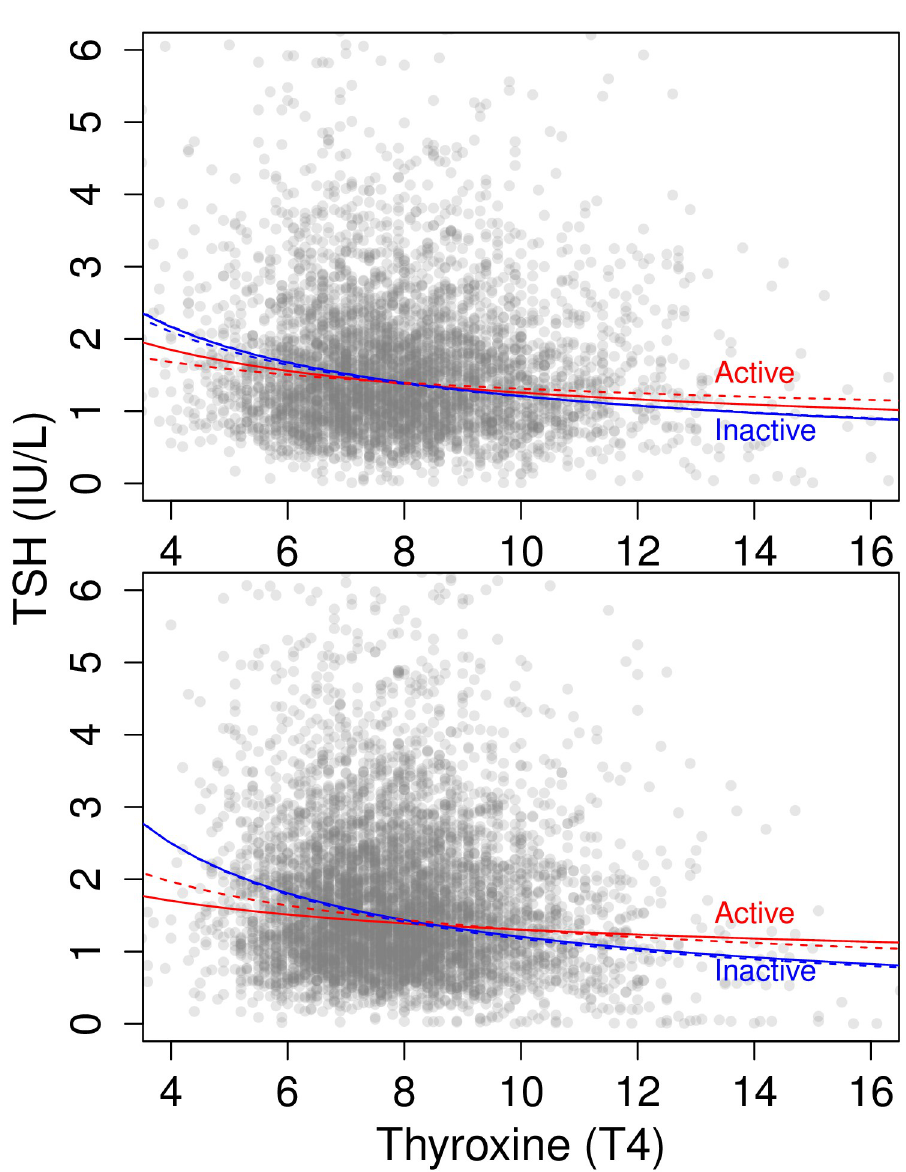
Fig 2. Physical activity’s relationship to thyroid hormones. The relationship between TSH and T4. The 1999–2002 data is represented by the top graph while 2007–2012 is on the bottom. Slopes for bivariate regressions of ln- transformed values shown separately for subjects reporting physical activity (“Active”, red) or no physical activity (“Inactive”, blue) in their leisure time (PAD200/PAQ650, solid line) or occupation (PAQ180/PAQ665, dashed line).